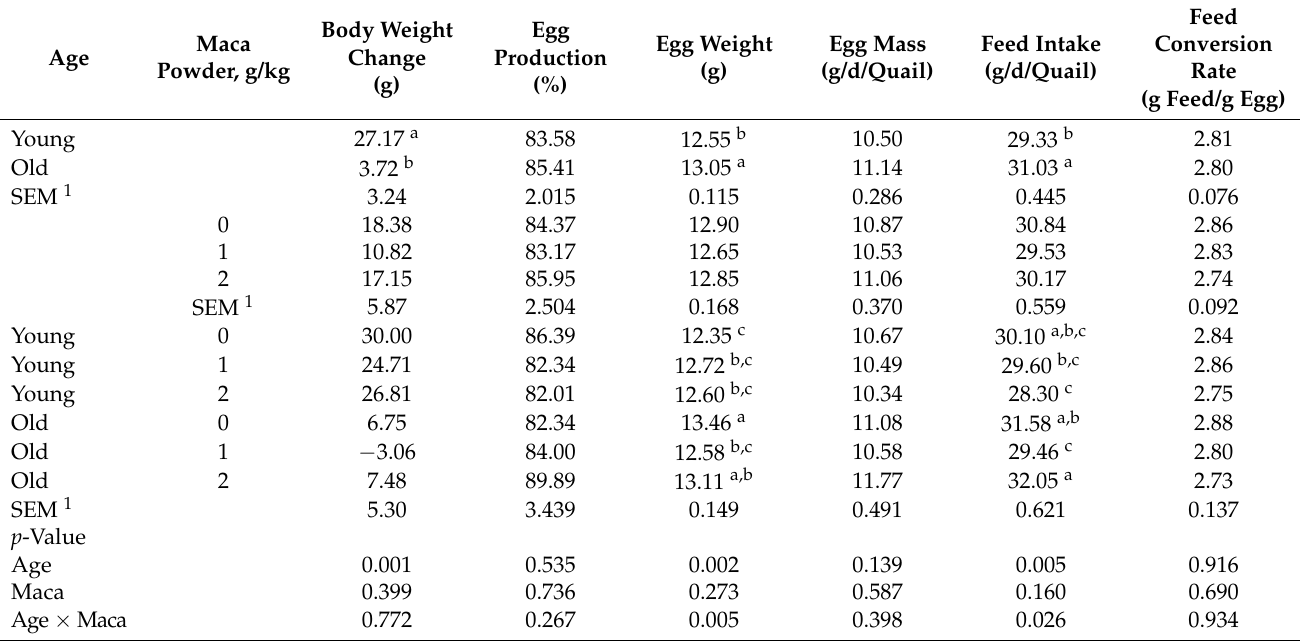
Table 2. Effects of Maca powder supplementation in diets of laying quails at different ages on performance